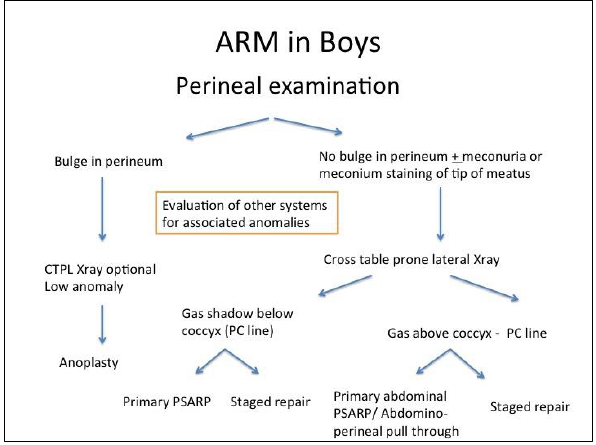
Figure 3: Algorithm for management of Male ARM at birth.